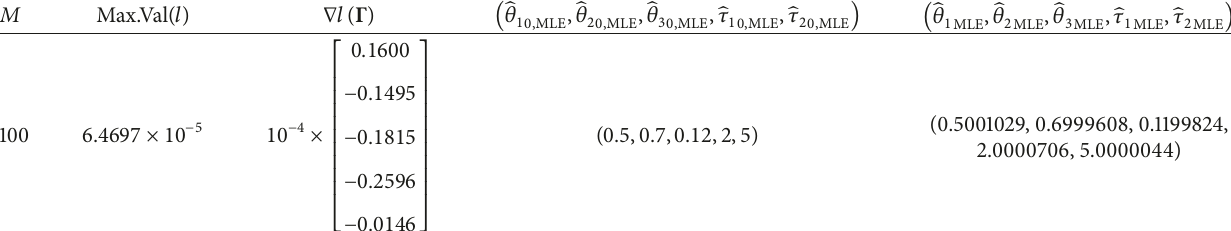
(̂𝜃 , ̂𝜃 , ̂𝜃 , ̂𝜏 , ̂𝜏 ) for DLDEM with two delays with ℎ = 0.1 . 1 MLE 2 MLE 3 MLE 1 MLE 2 MLE